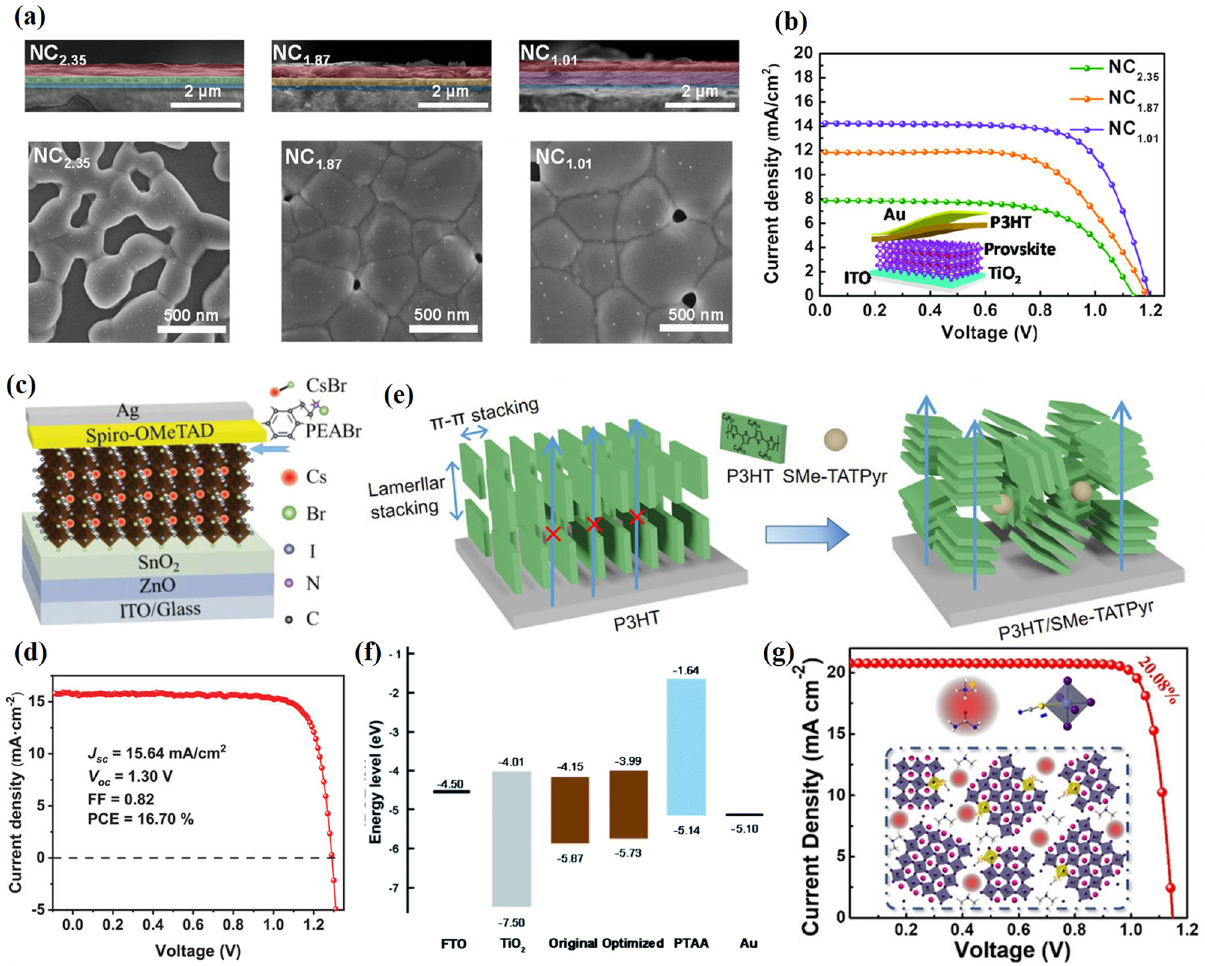
Figure 8: ( a ) The cross - sectional SEM images of NC 2.35 , NC 1.87 , and NC 1.01 and the SEM images of the annealed CsPbBrI 2 fi lm fabricated by NC 2.35 , NC 1.87 , and NC 1.01 . ( b ) The reverse scan J – V curves of NC 2.35 , NC 1.87 , and NC 1.01 . Reproduced with permission from ref. [ 98 ] . Copyright 2020, Wiley - VCH. ( c ) Structure diagram of the experimental device with the structure of Glass/ITO/ZnO/SnO 2 /CsPbI 2 Br/ ( PEABr + CsBr ) / Spiro - OMeTAD/Ag. ( d ) J – V characteristic curve of the best device with the optimized PEABr + CsBr. Reproduced with permission from ref.